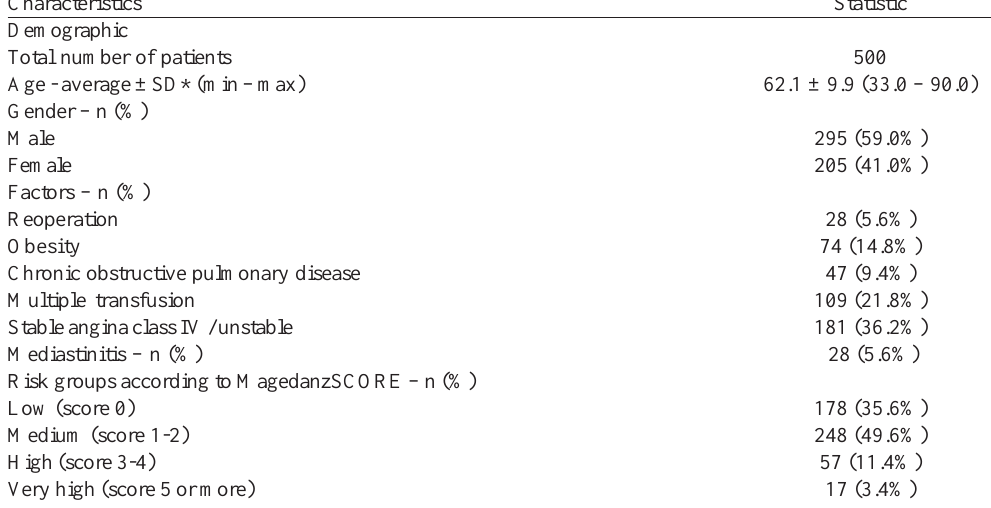
Table 2. Study population